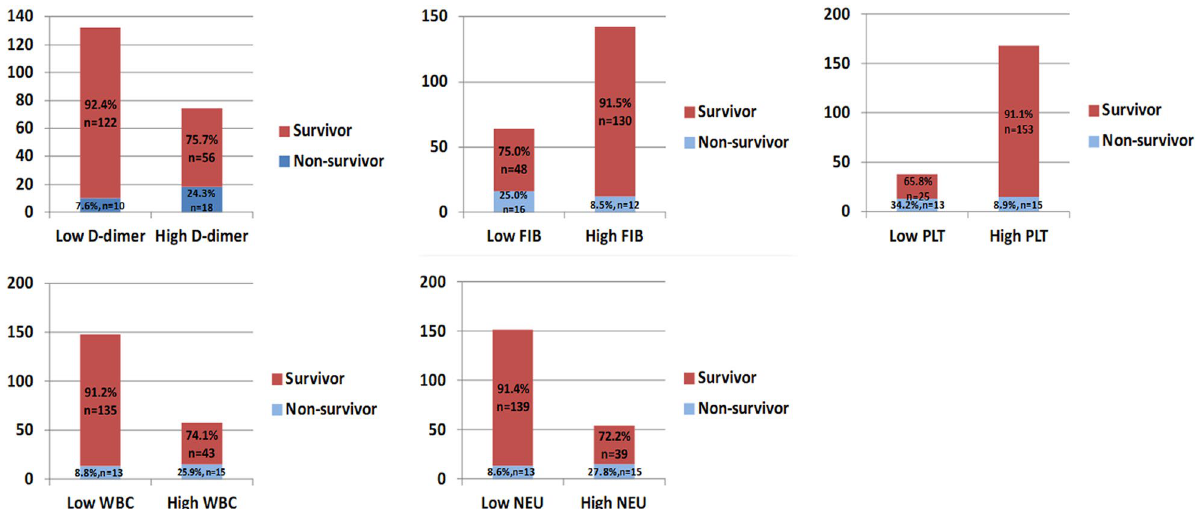
Figure 3. Distribution of the in-hospital mortality rate in patients with type A AAD according to categories of the indices including D-dimer, FIB, PLT, WBC and NEU. FIB, fibrinogen; PLT, platelet; WBC, white blood cells; NEU, neutrophil; AAD, acute aortic the patients with AAD. Elevated D-dimer may indicate larger area of aortic dissection and thrombosis in the patients. Moreover, the elevated levels of D-dimer may result from the interaction between systemic inflamma- tion and coagulation. It is generally recognized that inflammation may activate coagulation while the activation of coagulation system may also modulate inflammatory reaction.